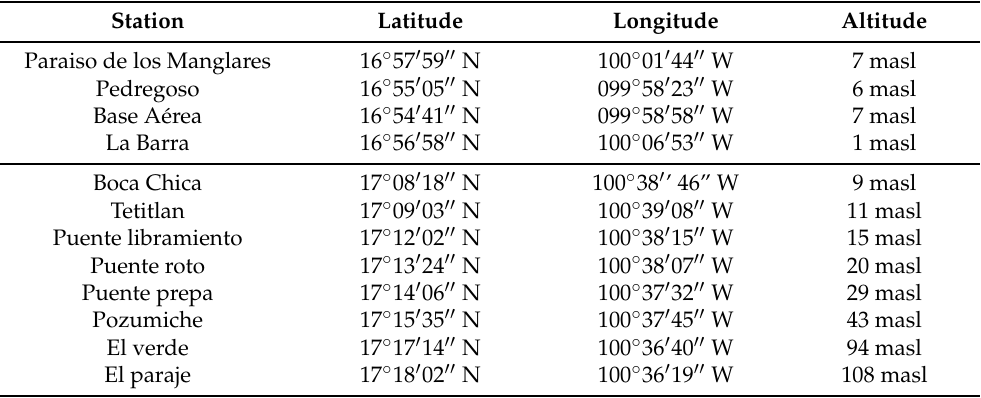
Figure 1. Geographical coordinates of sampling points in the Coyuca Lagoon. Table 1. Location and coordinates of sampling stations in the Coyuca Lagoon and the Tecpan